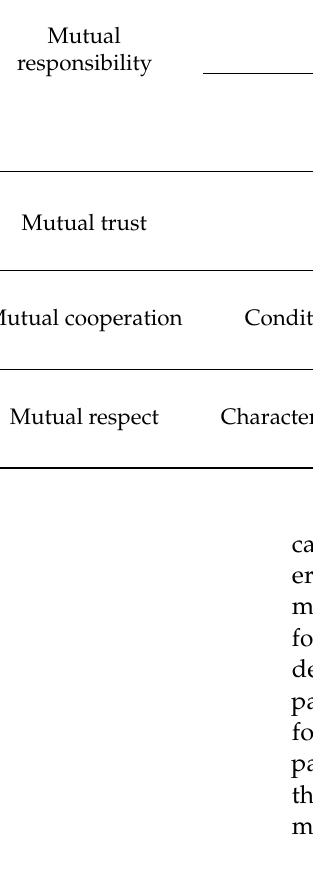
Table 4. Components of Final Confirmed Patient–Nurse